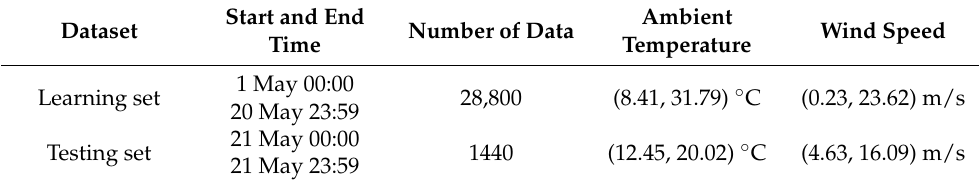
Table 1. Description of the learning and test